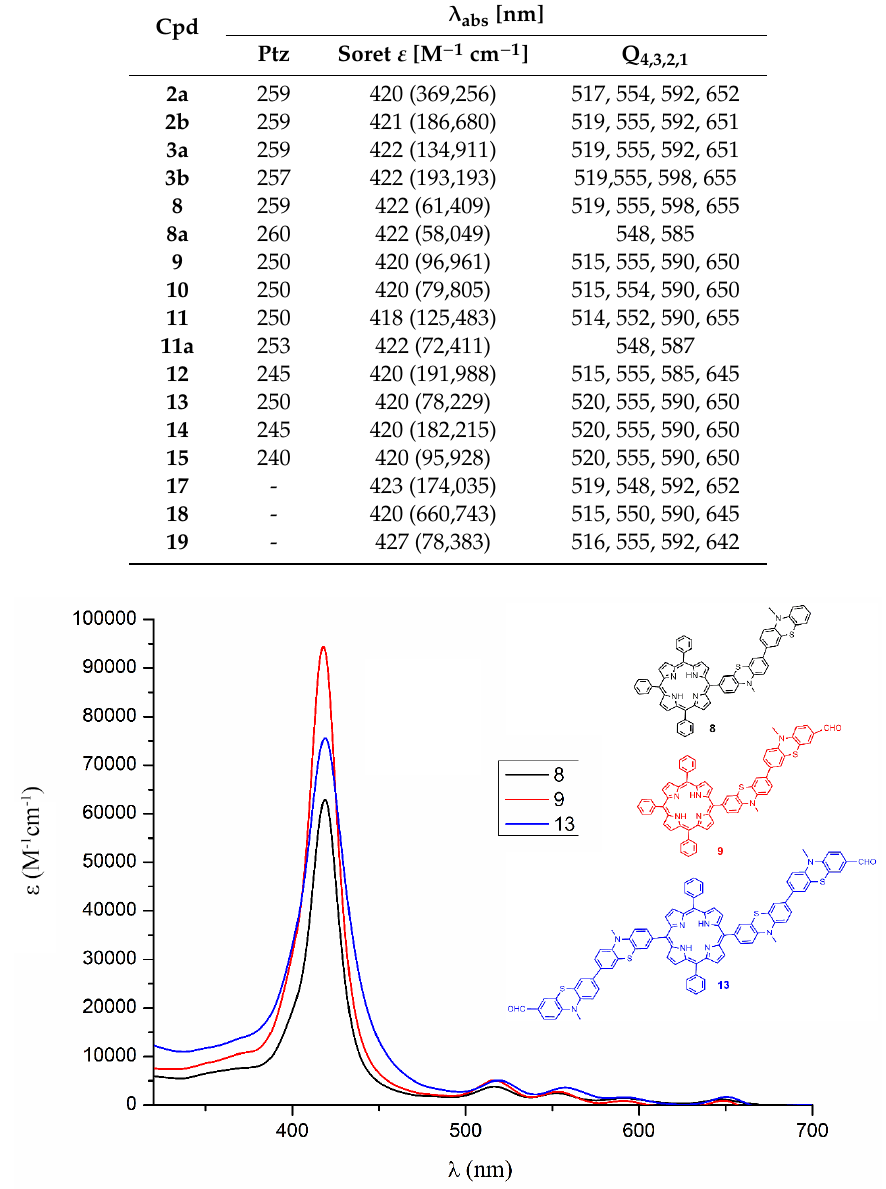
Figure 1. UV–Vis absorption spectra of phenothiazine-bridged porphyrin-phenothiazine dyads in DCM solution.